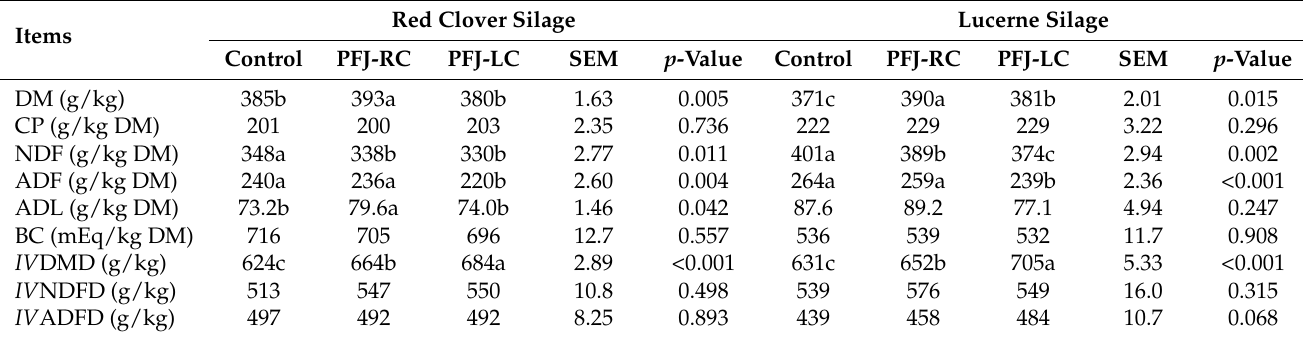
Table 5. Nutrient composition and in vitro digestibility of red clover silage and lucerne silage (n =